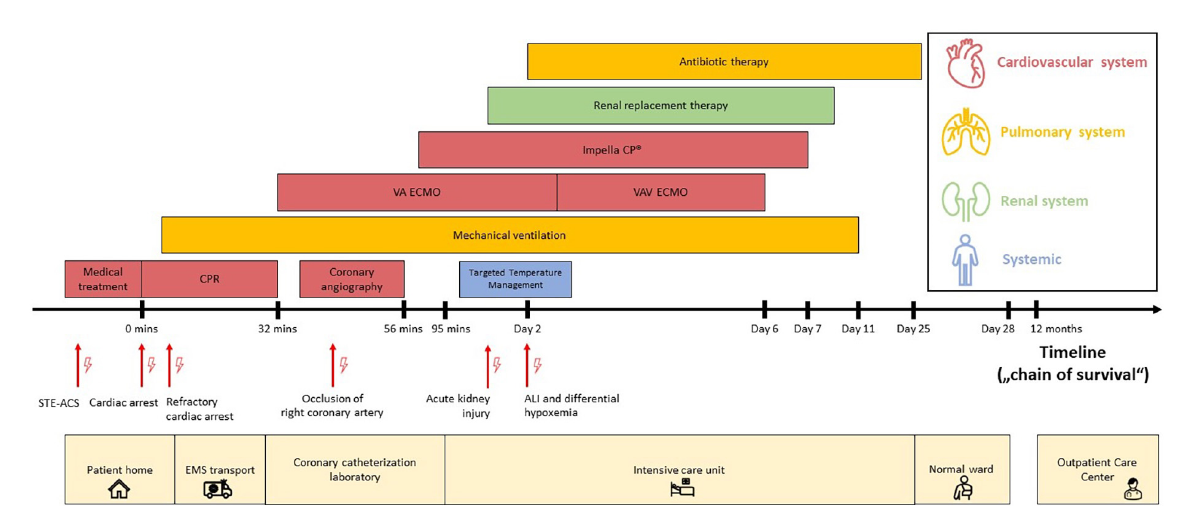
FIGURE1 Timeline (“chain of survival”) with data on the episodes of care. The timeline (“chain of survival”) reflects the pre-, intra- and post-hospital course of the cardiac arrest patient, which includes the period from onset of patient symptoms for suspected STE-ACS to hospital discharge and follow-up assessment in the ECPR Outpatient Care Program of the Cardiac Arrest Center. Each location is displayed at the bottom (light yellow color). Each critical clinical diagnosis is highlighted with red arrows (and lightning symbols) at the timeline. The provided medical procedures are colorized by organ system: cardiovascular system (red), pulmonary system (dark yellow), renal system (green) and non-specific (blue). The image scaling does not correlate with the actual time. Abbreviations: acute lung injury (ALI); cardiopulmonary resuscitation (CPR); emergency medical service (EMS); left ventricle (LV); ST-segment elevation acute coronary syndrome (STE-ACS); veno-arterial extracorporeal membrane oxygenation (VA ECMO); veno-arterio-venous ECMO (VAV ECMO).